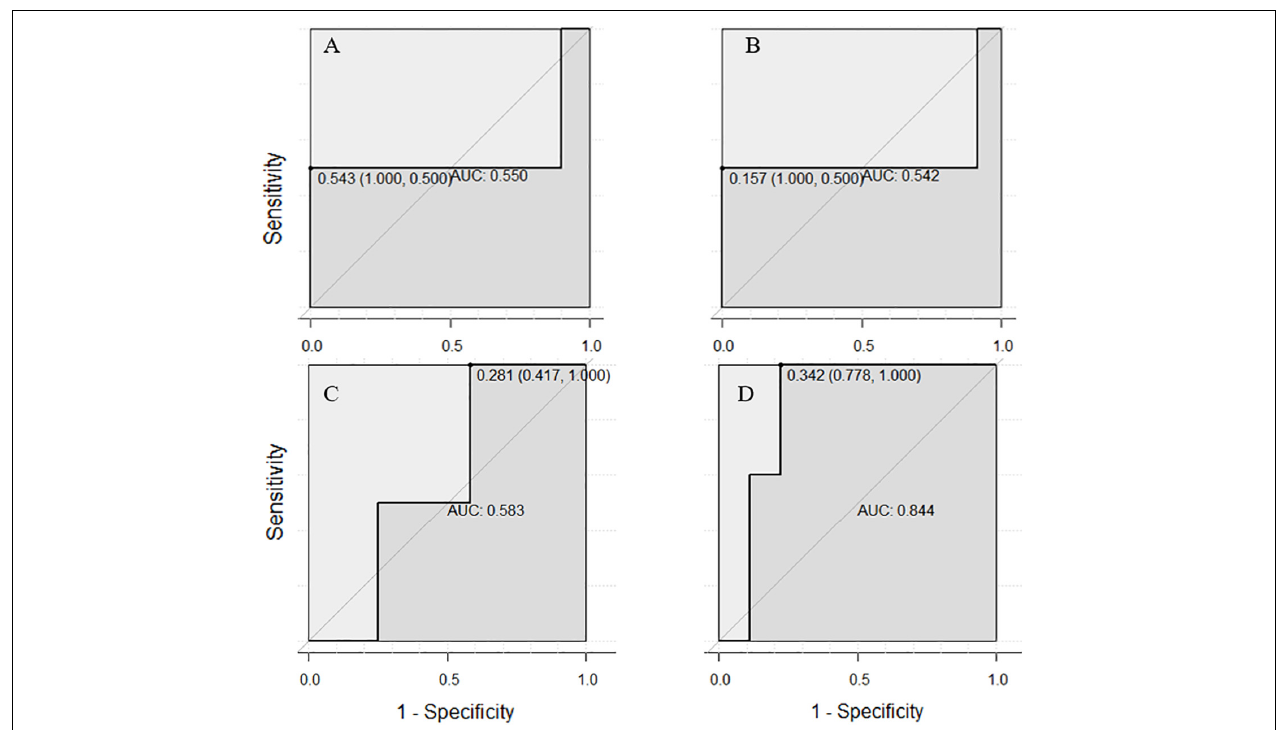
FIGURE 8 | Receiver operating characteristic curves for two-back-related frontal P3 amplitude (A) , P2 latency (B) , and DSM-related theta ERS (C) , and their combination based on electrode sites selected from the ANOVA test (D) using the LR model.